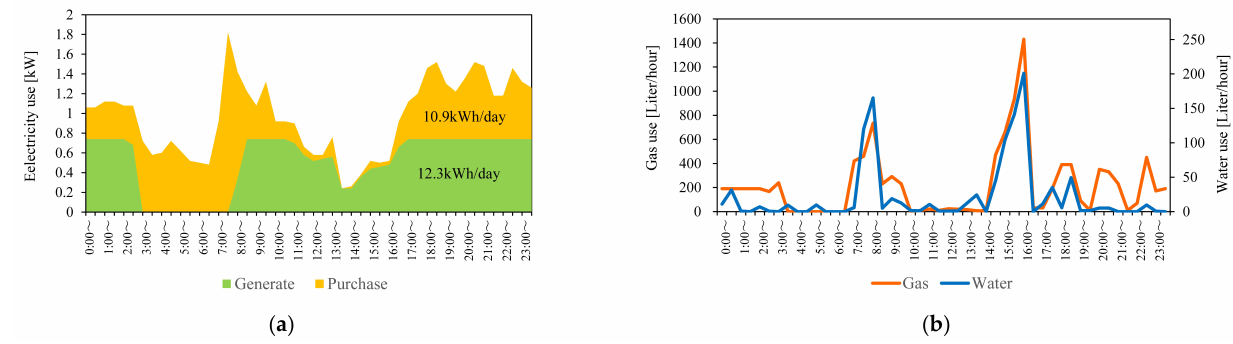
Figure 3. Variation of daily energy use (example data of a flat on 1 February): ( a ) electricity generated by CGS and purchased; ( b ) gas use (except for CGS) and water use.